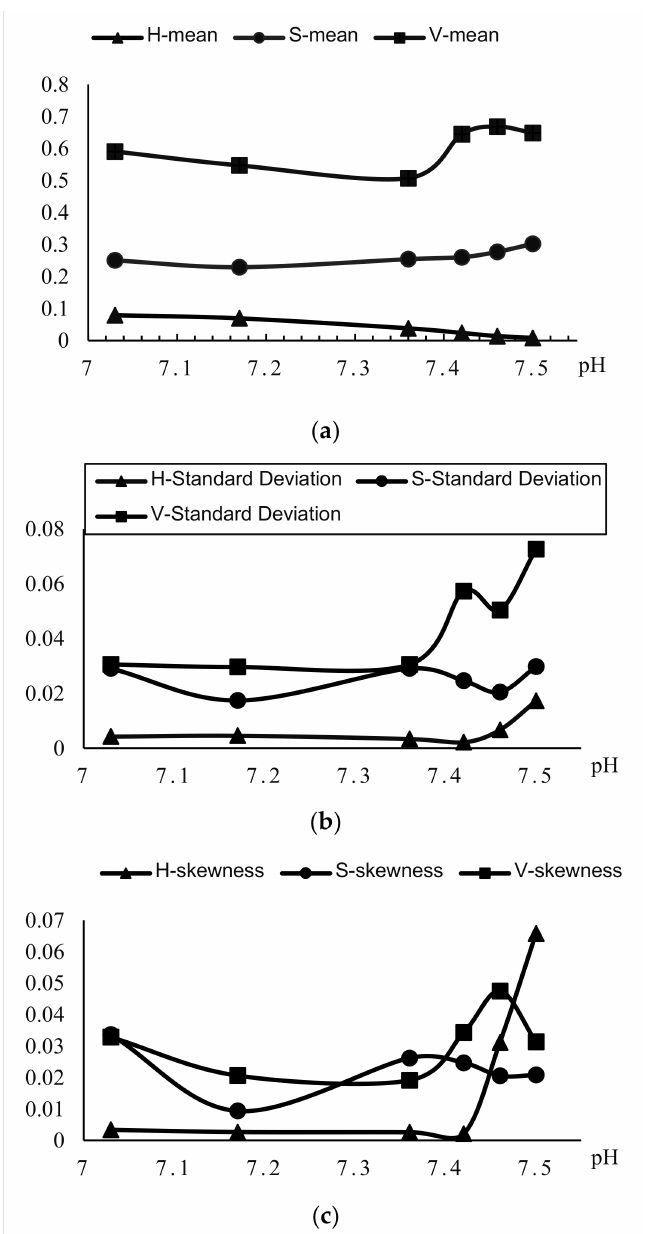
Figure 7. ( a ) Trend graph of the average hue in HSV color space; ( b ) trend graph of variance in HSV color space; ( c ) trend graph of slope in HSV color